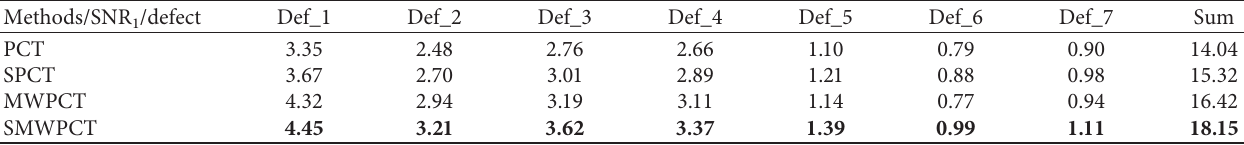
Table 1: SNR 1 of different methods.